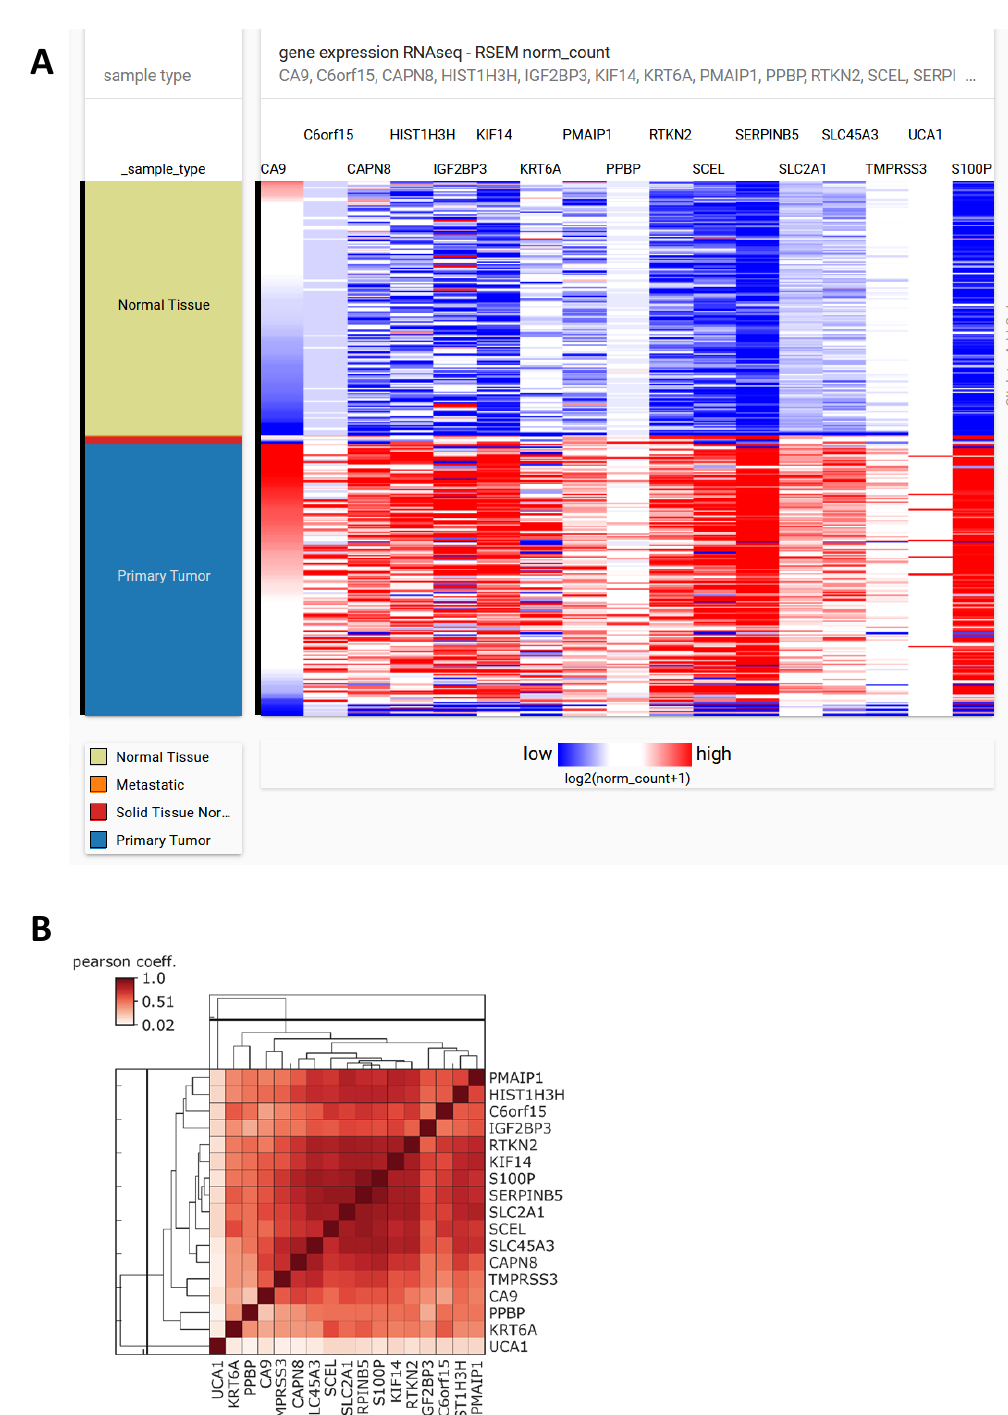
Figure 4. ( A ) The expression profile of CA9, S100P, and prognostic 15 gene signature panel for Early Stage Pancreatic Ductal Adenocarcinoma in 179 samples of pancreatic adenocarcinoma and 171 of normal pancreatic tissue extracted from Xena (TCGA target GTEx). ( B ) Pearson correlation coe ffi cient diagram of analyzed genes. CA9 is positively correlated with the 15 gene signature panel as well as S100P (Supplementary